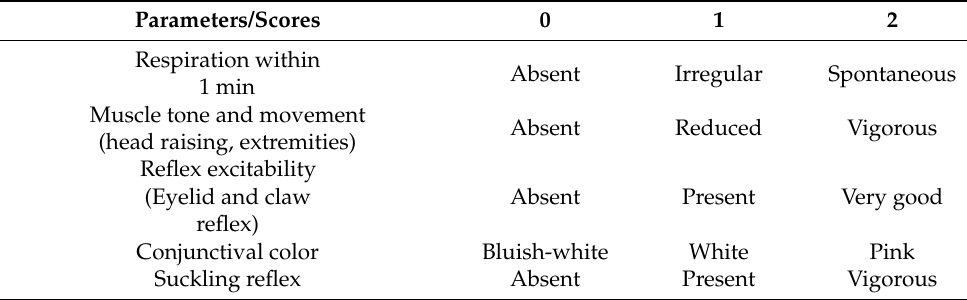
Table 5. Calf vitality score sheet recommended by Vollhardt